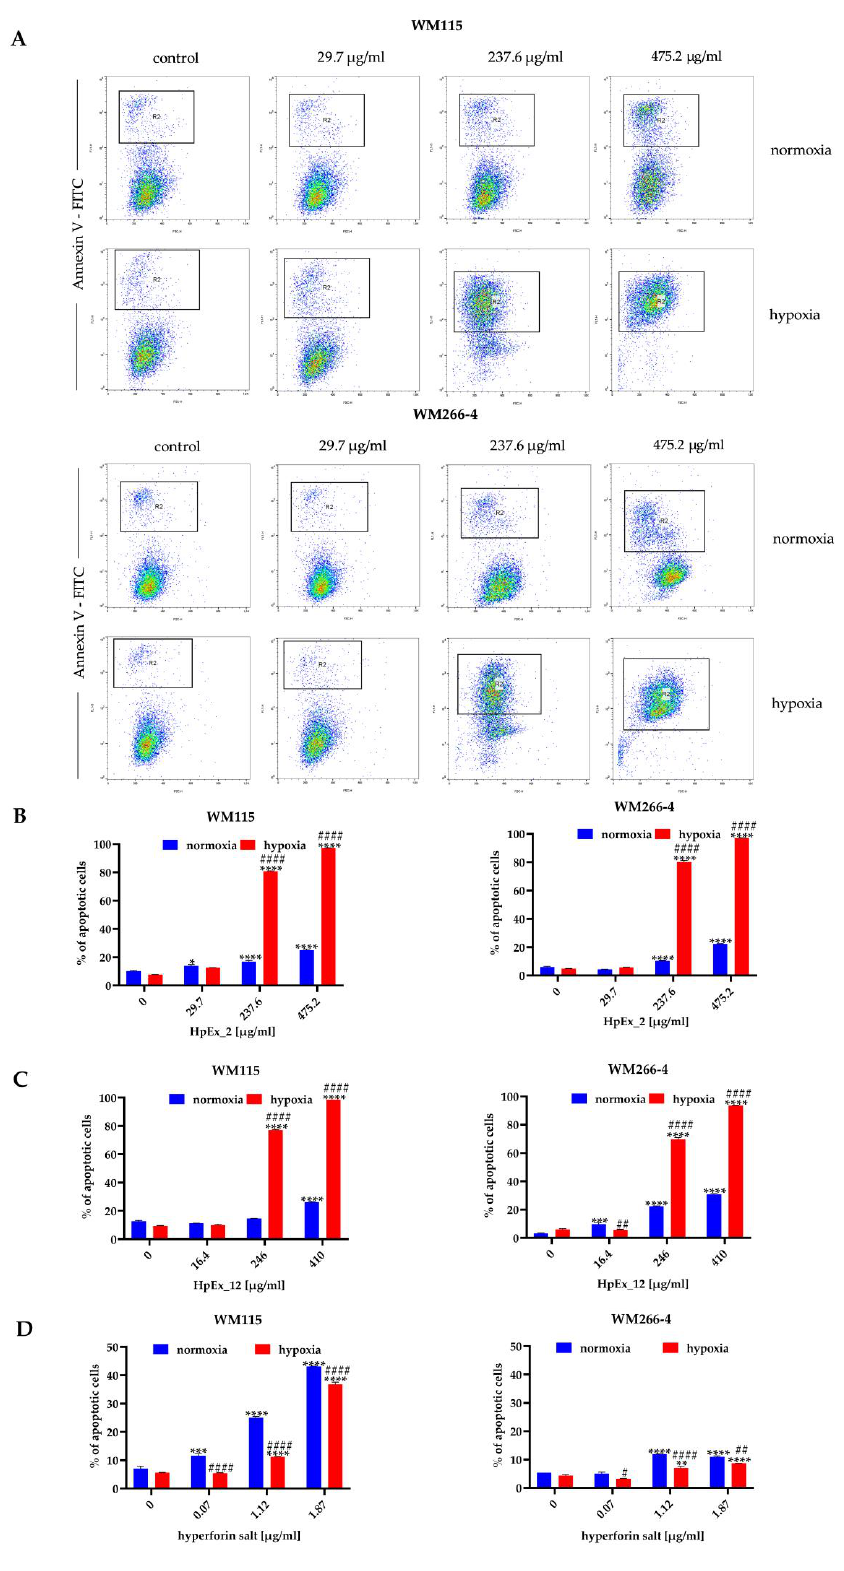
Figure 2. Detection of apoptosis in the WM115 and WM266-4 melanoma cells treated with ethanolic extracts of Hypericum perforatum and hyperforin salt, cultured under normoxia (blue bars) and hypoxia (red bars), determined by FITC-conjugated Annexin V staining in flow cytometry.